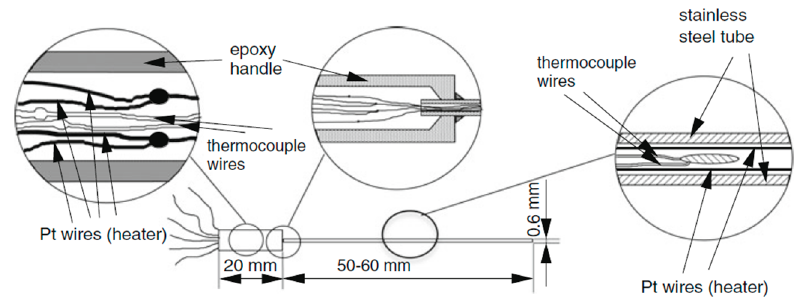
Figure 2. Sketch of the thermal conductivity